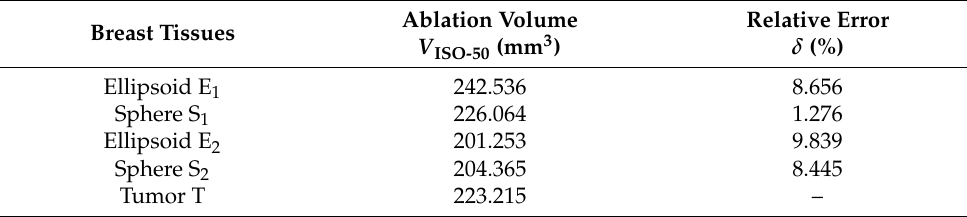
Table 4. Calculated ablation volumes and relative errors in the equivalent tumor models. Breast